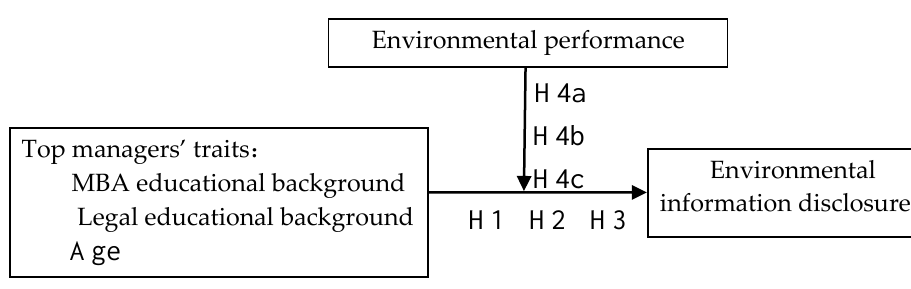
Figure 1. Research framework.